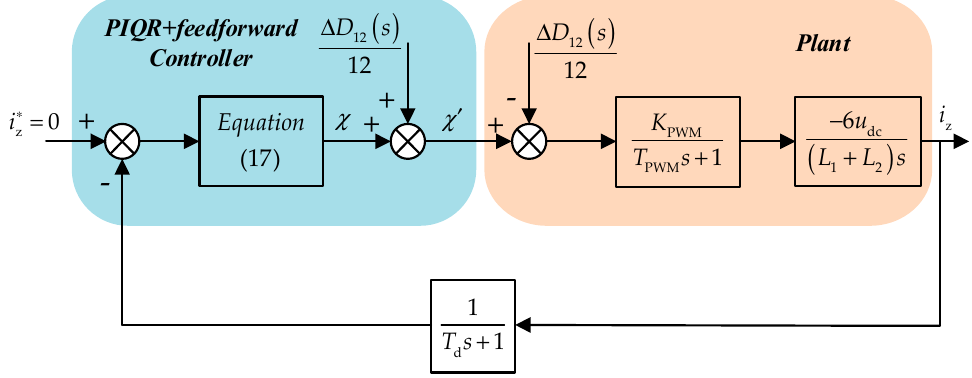
Figure 8. Control system block diagram of paralleled converters.